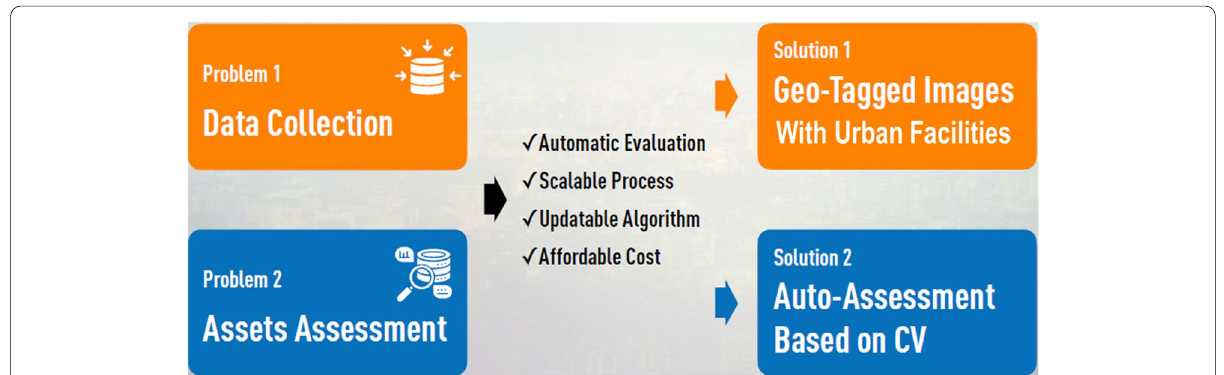
Fig 1 Solutions to the key problems for developing extendable